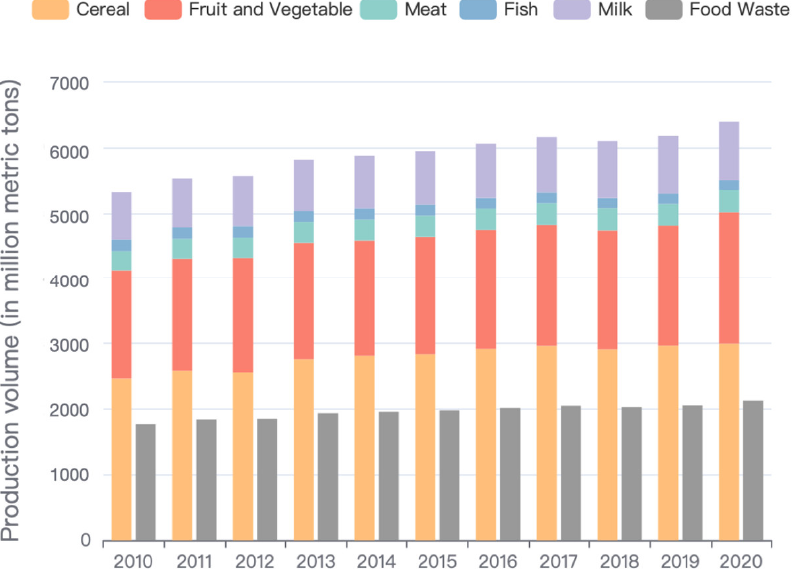
Figure 2. Total global production of several major food sources between 2010 and 2020, and estimated volume of food waste in the same year. Data were obtained from an online database [2,27– 29].